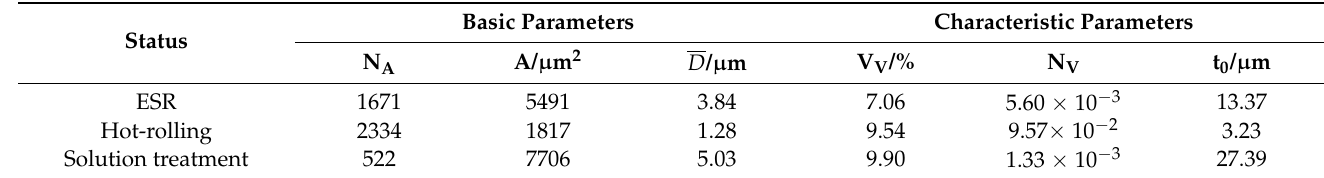
Table 6. Basic parameters and characteristic parameters of